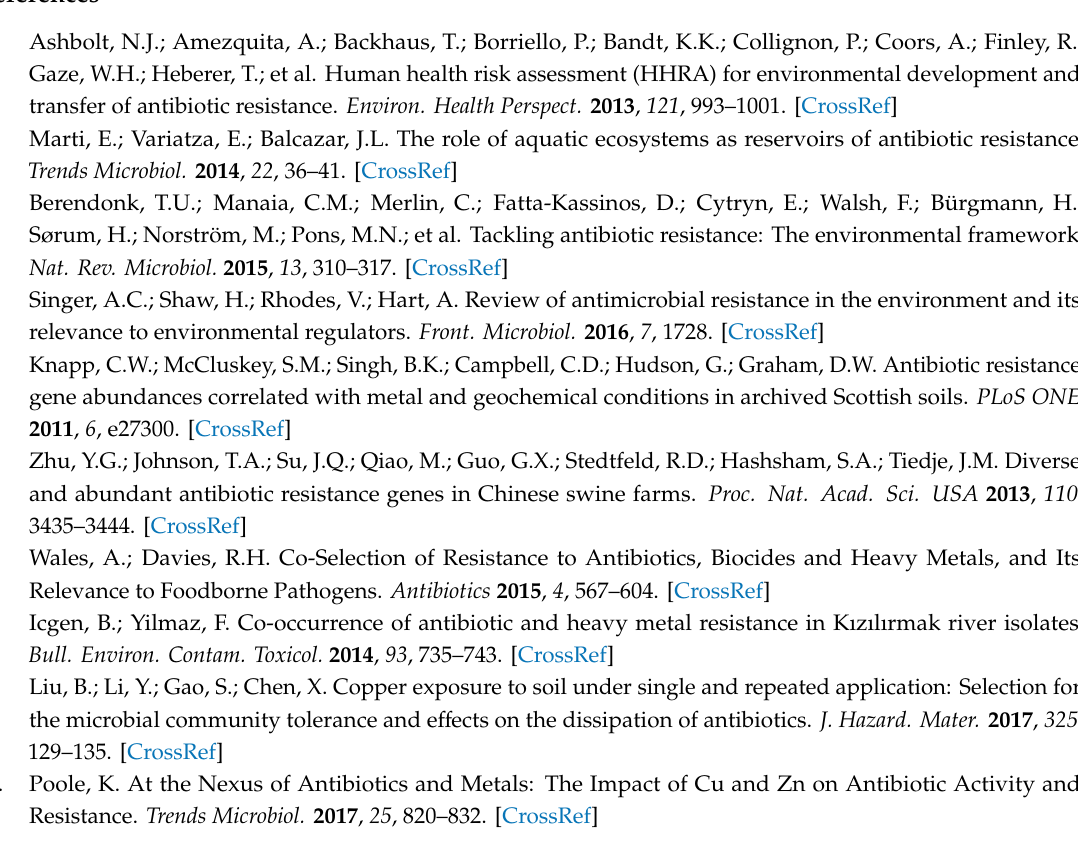
Table S1: Primers and PCR conditions for amplification of antimicrobial resistance